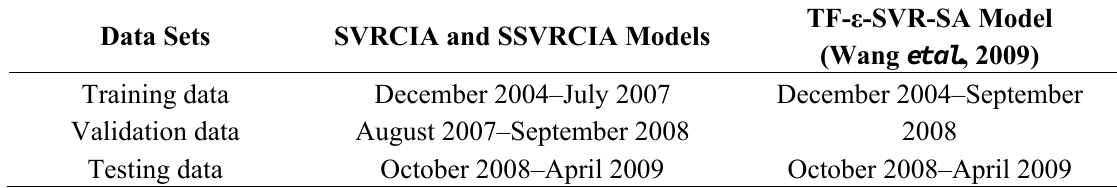
Table 2. Training, validation, and testing data sets of the proposed model.